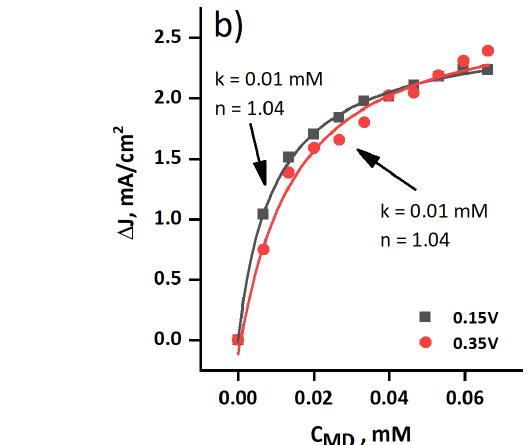
Measurements were performed in the phosphate–acetate buffer solution with the 37 mM potassium ferricyanide and 31 mM